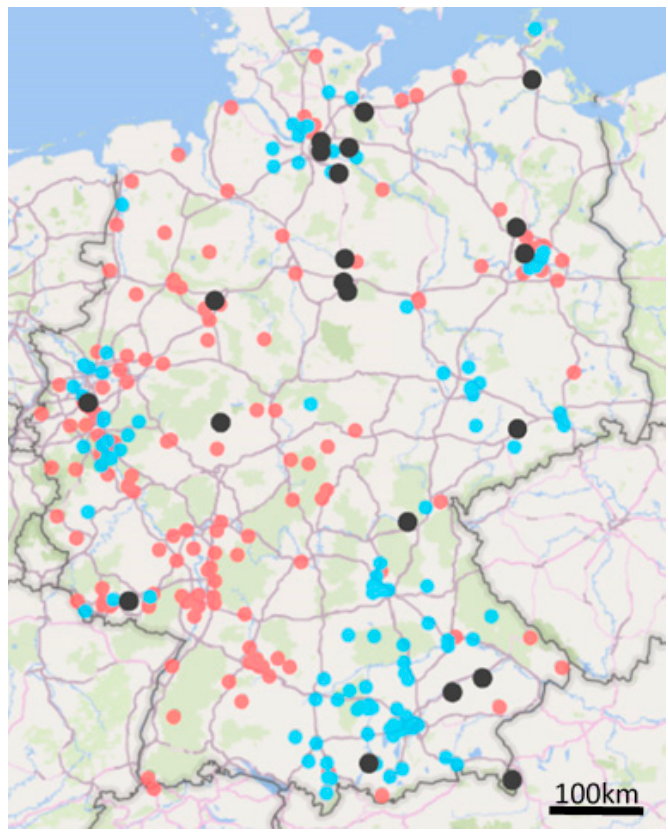
Figure 1. Sample origin, black—private breedings, blue—SYNLAB Vet, red—LABOKLIN.